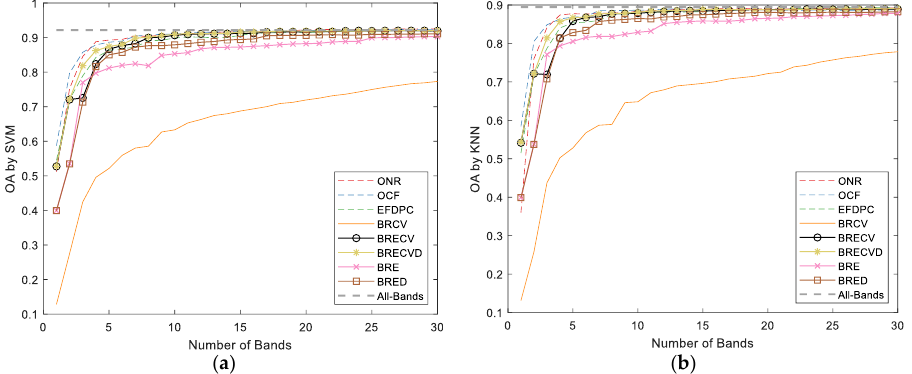
Figure 6. OA curves produced by SVM and KNN classifiers for the Salinas data set. ( a ) The OA curves produced by SVM classifier. ( b ) The OA curves produced by KNN classifier.